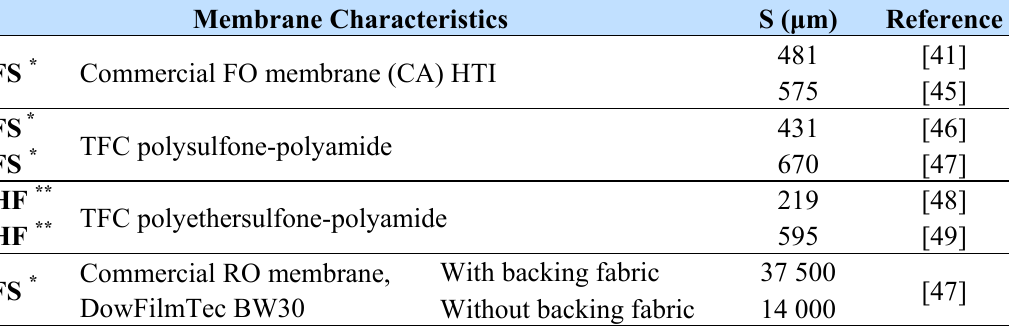
Table 1. The S-values reported in literature for some FO/PRO membranes and one commercial RO